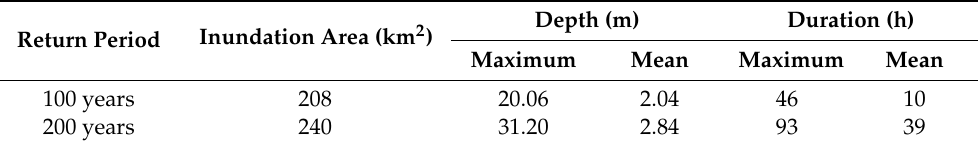
Table 4. Main information on inundated areas from the